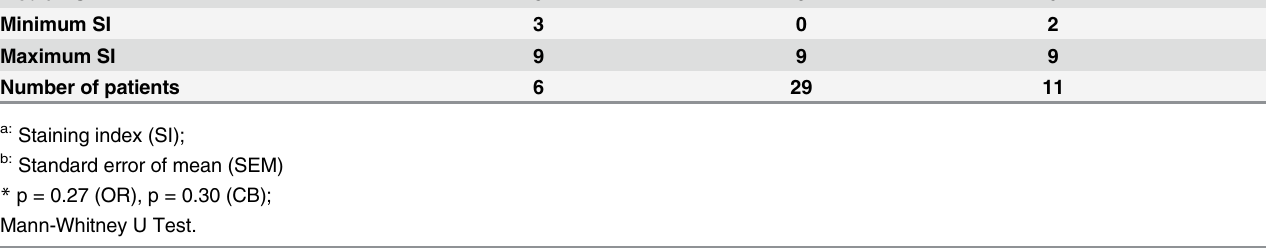
107/mm 2 ) in metastases; thus, MVD was significantly higher in metastases than in primary Table 3. Descriptive data for VEGF-A expression in metastases. VEGF-A expression in metastases Overall response